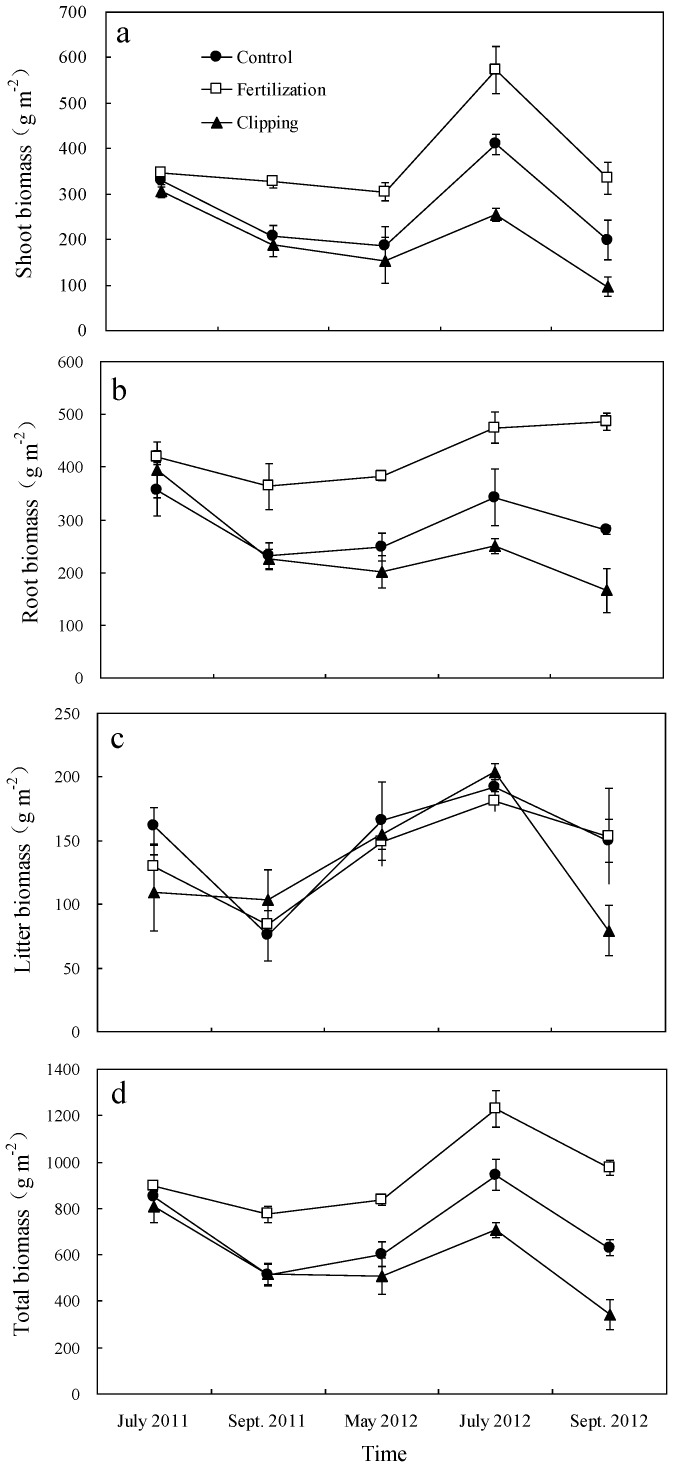
The shoot (a), root (b), litter (c) and total biomass (d) variation under the different treatments over time. Vertical bars represent standard error (SE). n = 5.